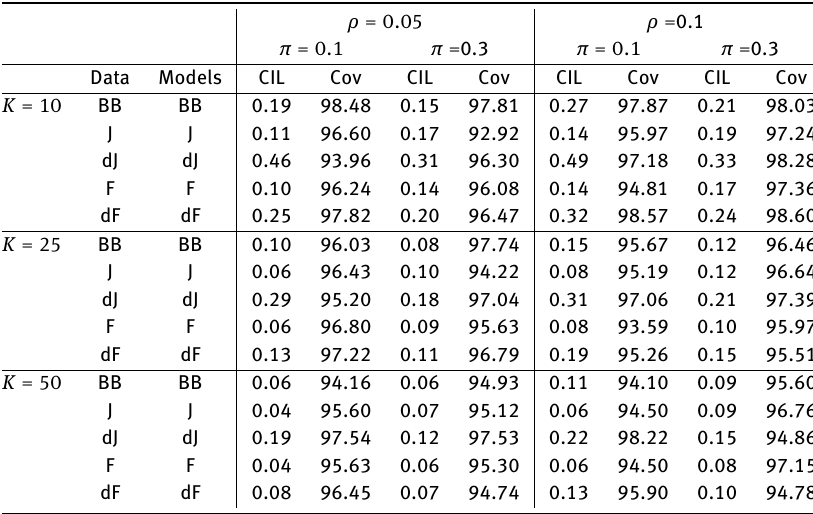
Table 5: Larger cluster simulations: Confidence interval length (CIL) and empirical coverage (COV) of two-sided PLCI for ρ with a nominal 95 confidence level for data generated from 5